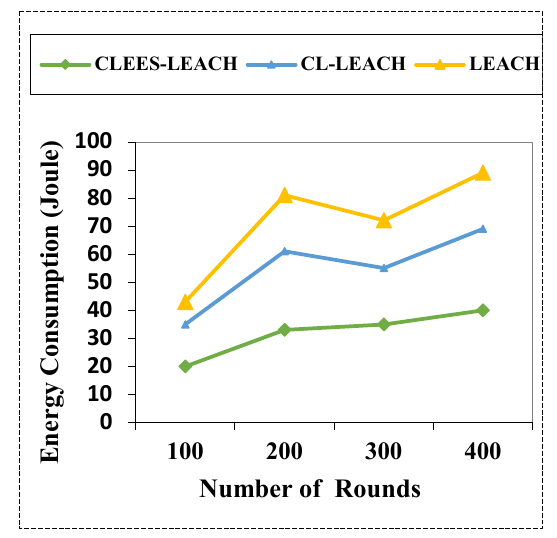
Figure 18. Graph of Energy Consumption for existing protocols and proposed